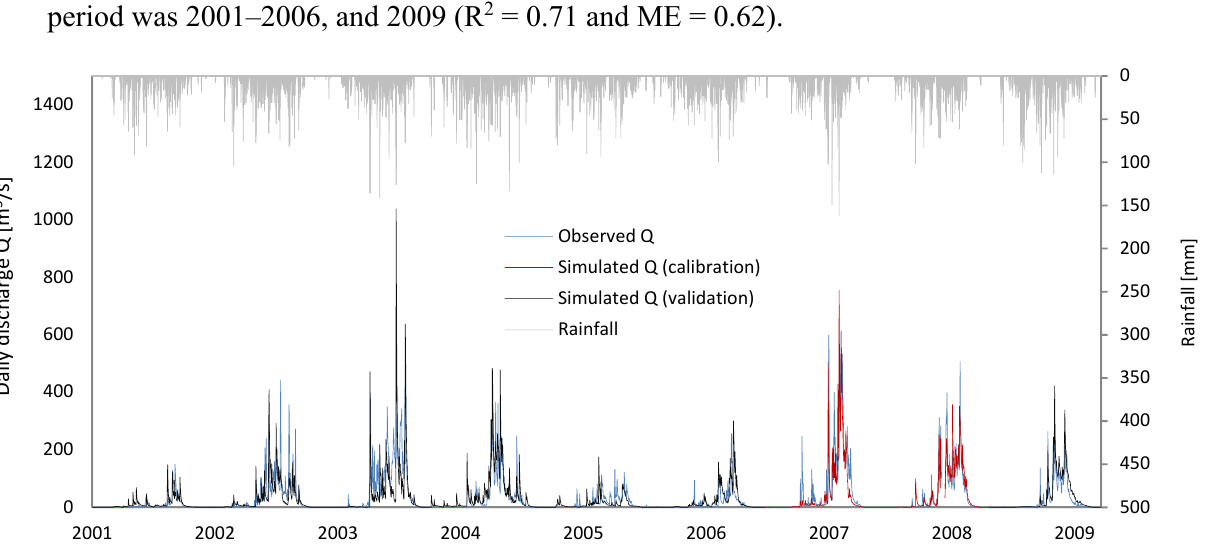
Figure 3. Simulated vs. observed daily discharge for the Atchérigbé sub-catchment (6978 km 2 ). Calibration period was 2007 to 2008 (R 2 = 0.89 and ME = 0.83), validation period was 2001–2006, and 2009 (R 2 = 0.71 and ME = 0.62).